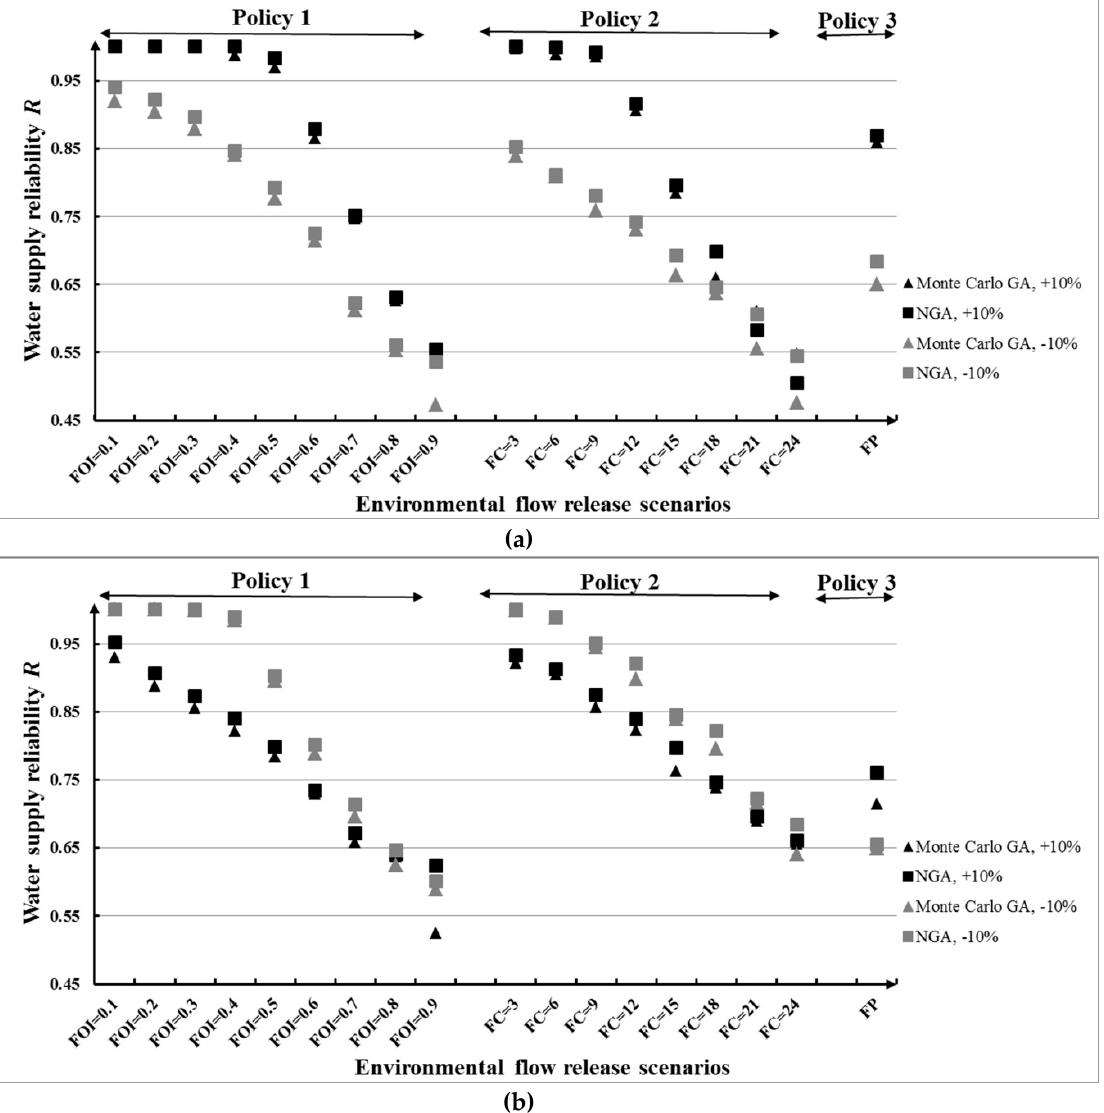
Figure 14. Water supply reliability R for different e-flow release policies under different inflow conditions: ( a ) Change of average value and ( b ) change of standard deviation value.